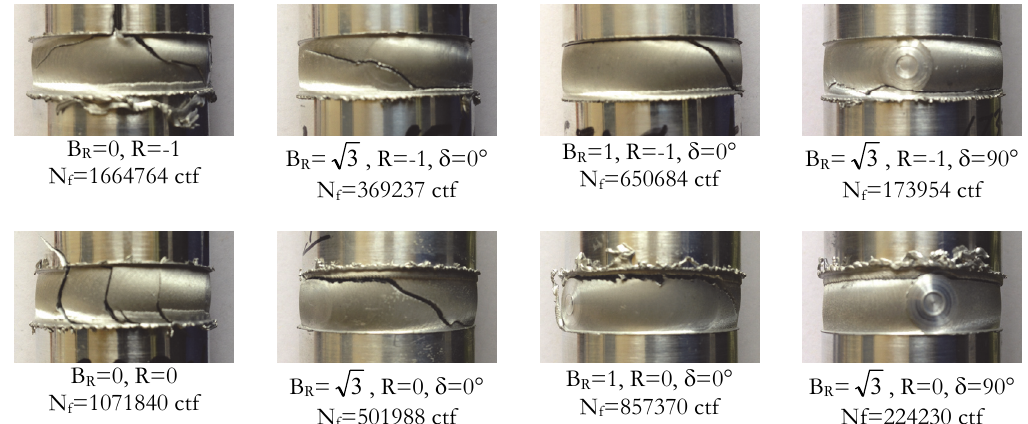
Figure 3: Examples of the observed macroscopic cracking behaviour under biaxial fatigue loading (ctf=cycles to